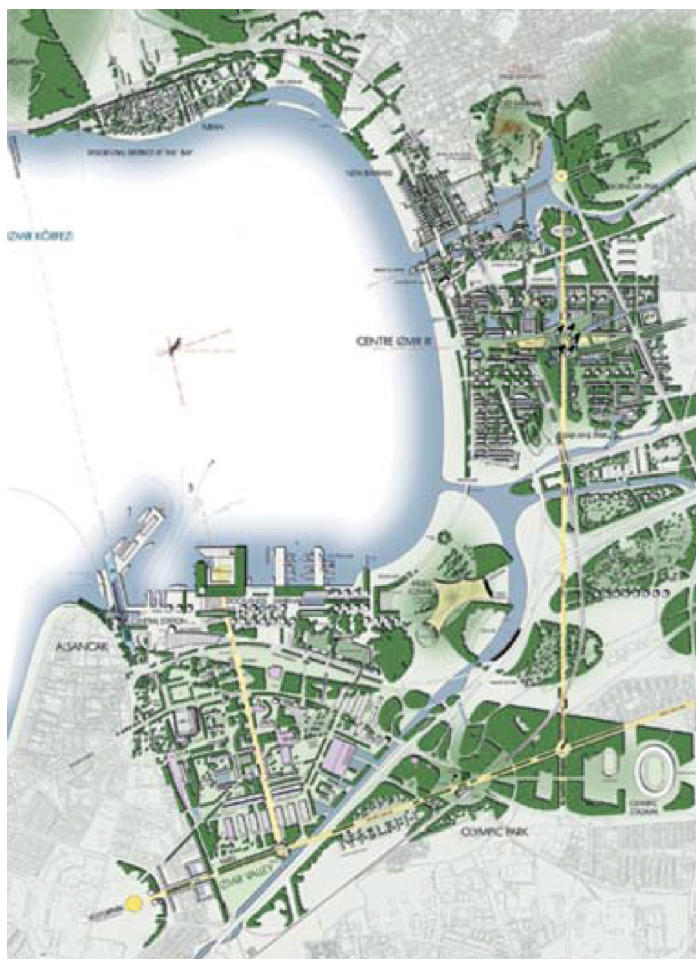
Figure 2. The Master Plan of the Winning Project by the German urban planner